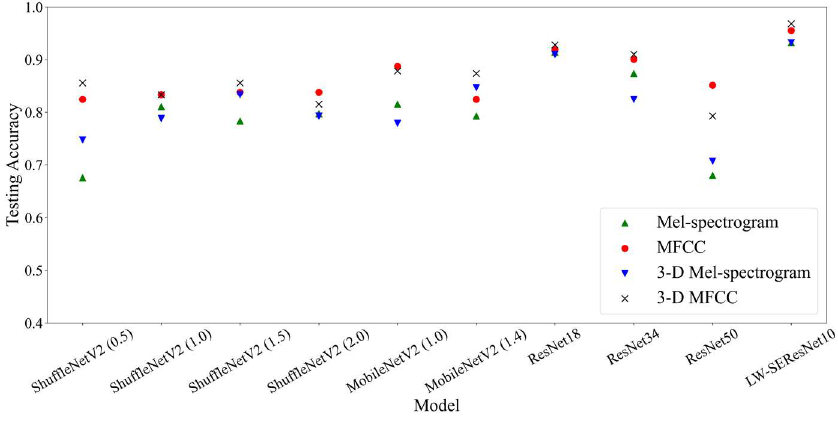
Figure 7. The testing accuracy of the multiple network models under different